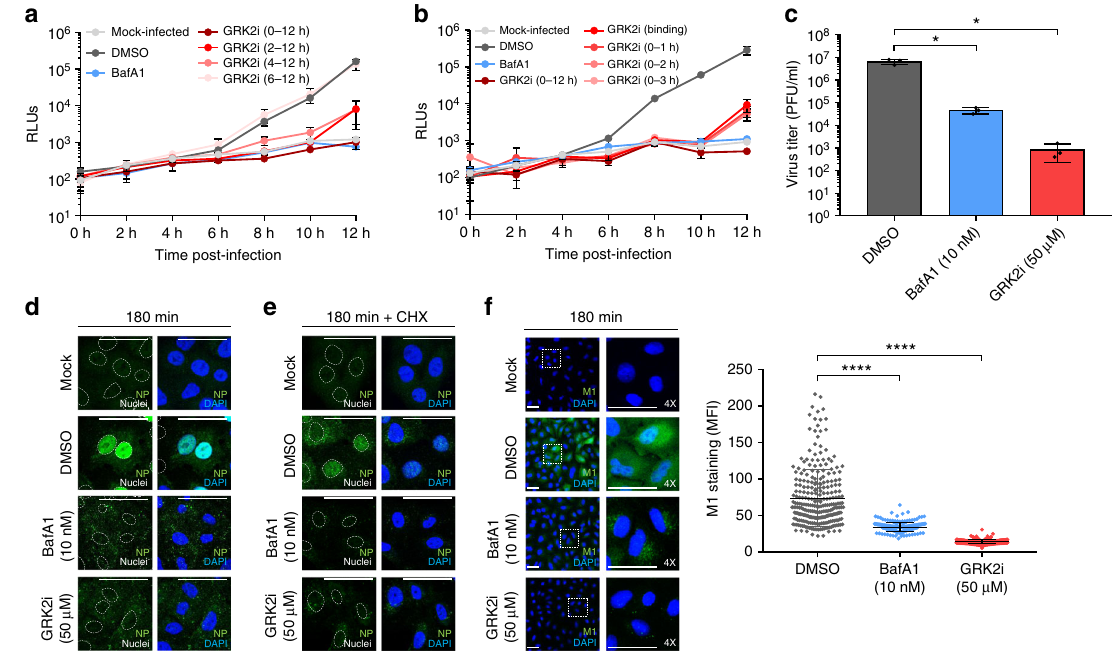
Fig. 4 GRK2 is required for ef fi cient virus uncoating. a A549 cells were infected on ice with a recombinant IAV encoding luciferase (MOI = 1 PFU/cell). At the indicated times post-infection, GRK2i was added to the cells at a fi nal concentration of 50 µ M. The ef fi ciency of viral replication was determined by luminescence measurement in live cells every 2 h. b A549 were infected and processed as described in ( a ) but GRK2i was added during virus binding or during the fi rst 1 to 3 h of infection, followed by a washing step and the replacement by inhibitor-free medium. One representative out of three independent experiments, each performed in triplicates, is shown in ( a , b ). c A549 cells were infected with A/WSN/33 (MOI = 1 PFU/cell) and treated with 50 µ M GRK2i, 10 nM BafA1 or control medium for 3 h, after which they were incubated in inhibitor-free medium. At 12 hpi, supernatants were collected and virus titers were determined by plaque assay. Mean values from three independent experiments are depicted. d A549 cells were treated with the indicated concentrations of the different compounds for 1 h and infected on ice with IAV A/WSN/33 (H1N1, MOI = 5 PFU/cell) for 1 h to synchronize infection. Cells were incubated at 37 °C for 3 h in the presence of the compounds, fi xed and stained for viral nucleoprotein (NP, green) and nuclei (blue). Representative images are shown (scale bar corresponds to 40 µ m). The white lines indicate the position of the nucleus. e Cells were infected and processed as in ( d ) but in the presence of cycloheximide (100 µ g/ml). Representative images from three independent experiments are shown ( d , e ). f A549 cells were treated with the indicated concentrations of the different compounds for 1 h and infected on ice with IAV A/WSN/33 (H1N1, MOI = 25 PFU/cell) for 1 h to synchronize infection. Cells were incubated at 37 °C for 3 h in presence of compounds, fi xed and stained for viral M1 protein (M1, green) and nuclei (blue). Representative images are shown (scale bar corresponds to 40 µ m). The mean fl uorescence green intensity (MFI) in each cell ( n > 200) was quanti fi ed using ImageJ. One representative out of three independent experiments is shown. For all panels, error bars represent standard deviation (from >200 cells) and statistical signi fi cance was determined by unpaired t -test (ns (non-signi fi cant) = P > 0.05; * P ≤ 0.05; ** P ≤ 0.01; *** P ≤ 0.001; **** P ≤